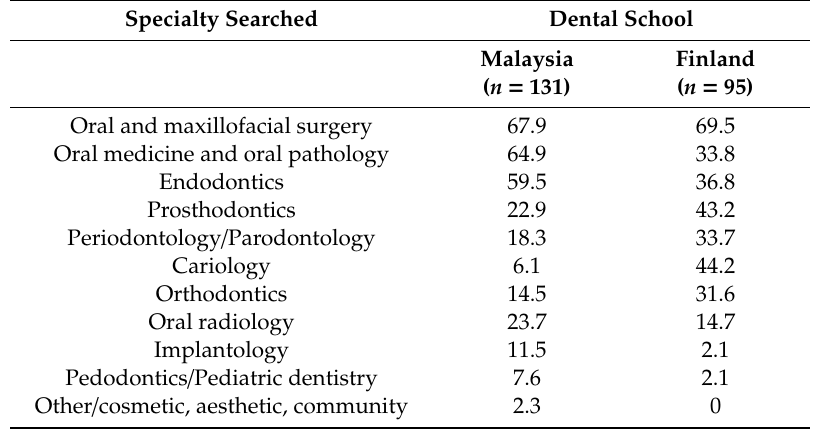
Gender: Four missing values. Table 2. Percentages of most recent searches according to dental specialty and school ( n = 226).